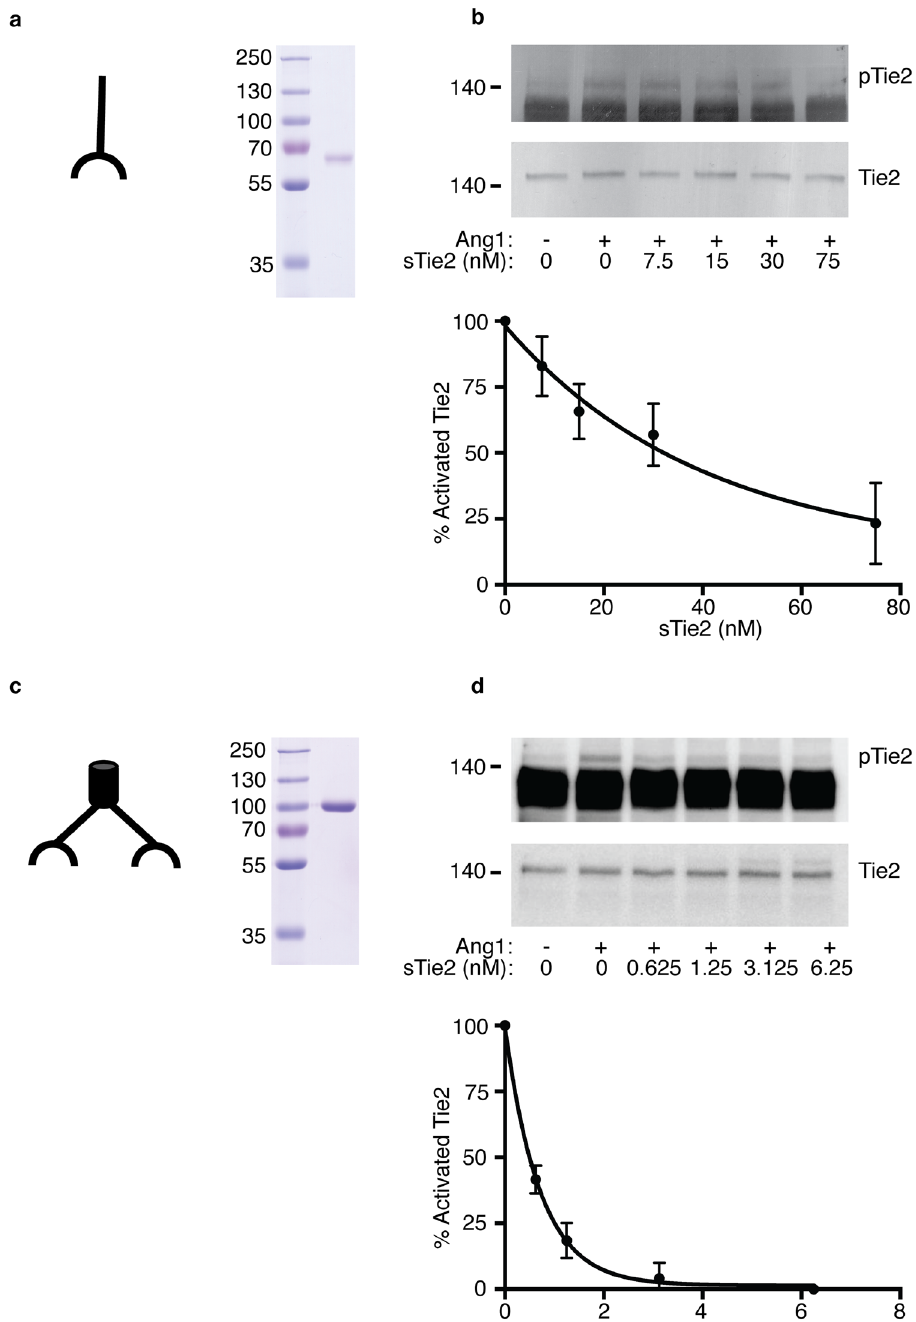
Figure 4. Effects of sTie2 on Ang1 activation of cell surface Tie2. ( a ) Coomassie-stained gel showing purified monomeric sTie2 used in experiments, mass markers are indicated in kDa. ( b ) Effects of sTie2 on Ang1 activation of cellular Tie2. HUVEC were stimulated with 0.18 nM Ang1 for 15 minutes in the presence of monomeric sTie2 concentrations shown. Cells were lysed and activated cellular Tie2 detected with anti- phosphoY 992 -Tie2 immunoblotting. Blots were stripped and probed with anti-Tie2 to quantify loading of tracks. ( c ) Blots from three independent experiments assessing cellular Tie2 activation were quantified by densitometric scanning and presented as mean and SEM for the effects of sTie2 on cellular Tie2 activated with Ang1. ( d ) Coomassie-stained gel showing purified dimeric engineered sTie2 used in experiments, mass markers are indicated in kDa. ( e ) Effects of dimeric sTie2 on Ang1 activation of cellular Tie2. HUVEC were stimulated with 0.18 nM Ang1 for 15 minutes in the presence of dimeric sTie2 concentrations shown. Cells were lysed and activated cellular Tie2 detected with anti-phosphoY 992 -Tie2 immunoblotting. Blots were stripped and probed with anti-Tie2 to quantify loading of tracks. ( f ) Blots from four independent experiments assessing cellular Tie2 activation were quantified by densitometric scanning and presented as mean and SEM for the effects of sTie2 on cellular Tie2 activated by Ang1. Images of blots have been cropped for